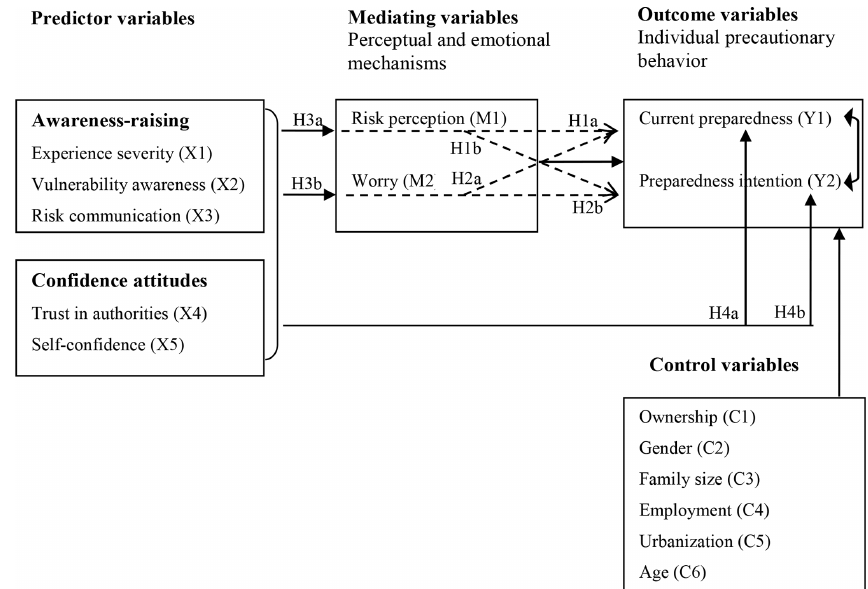
Figure 1. Model of flood-risk precautionary behavior (FPB) and hypotheses. (1) Dashed and straight arrows depict predicted mediation (indirect) and direct effects, respectively. (2) The two-way arrow between Y1 and Y2 indicates that these variables may be correlated without any assumed direct